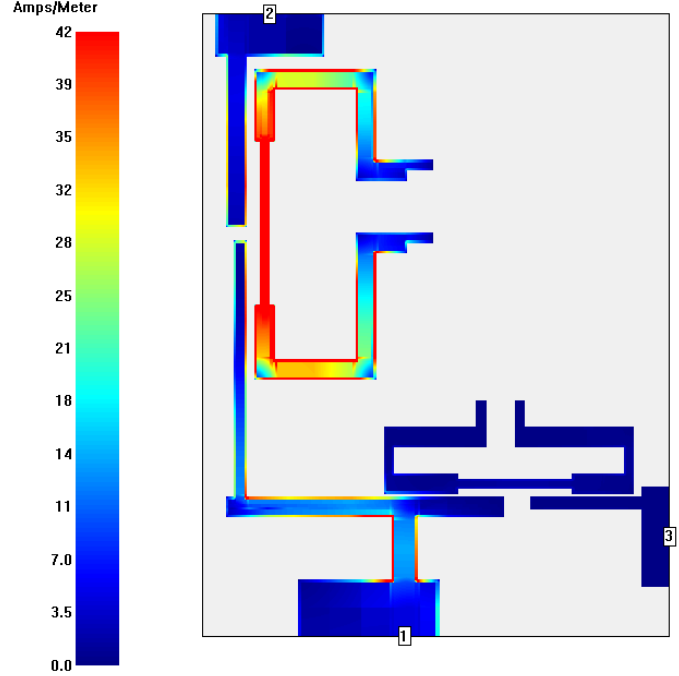
Table 1. Negative group delay